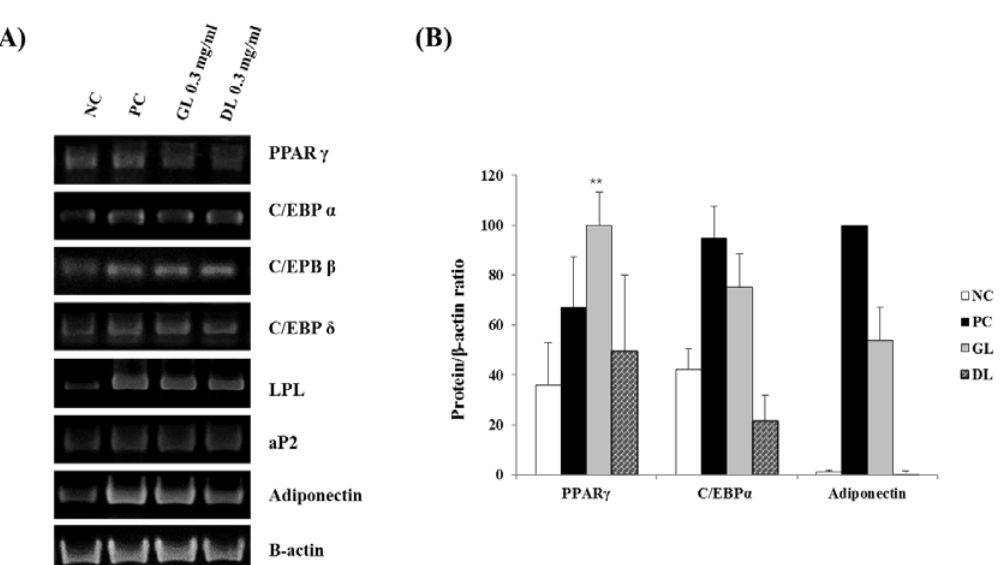
Figure 6. Effects of GL and DL on mRNA and protein expression of adipogenic genes in 3T3-L1 adipocytes. Cells were treated with GL and DL for eight days during differentiation and total RNA and protein content was isolated: ( A ) mRNA expression of the adipogenic genes in 3T3-L1 cells; and ( B ) protein expression of PPAR γ , C/EBP α , and adiponectin in 3T3-L1 cells. ** p < 0.01. Bars represent means ± SD from three independent experiments.